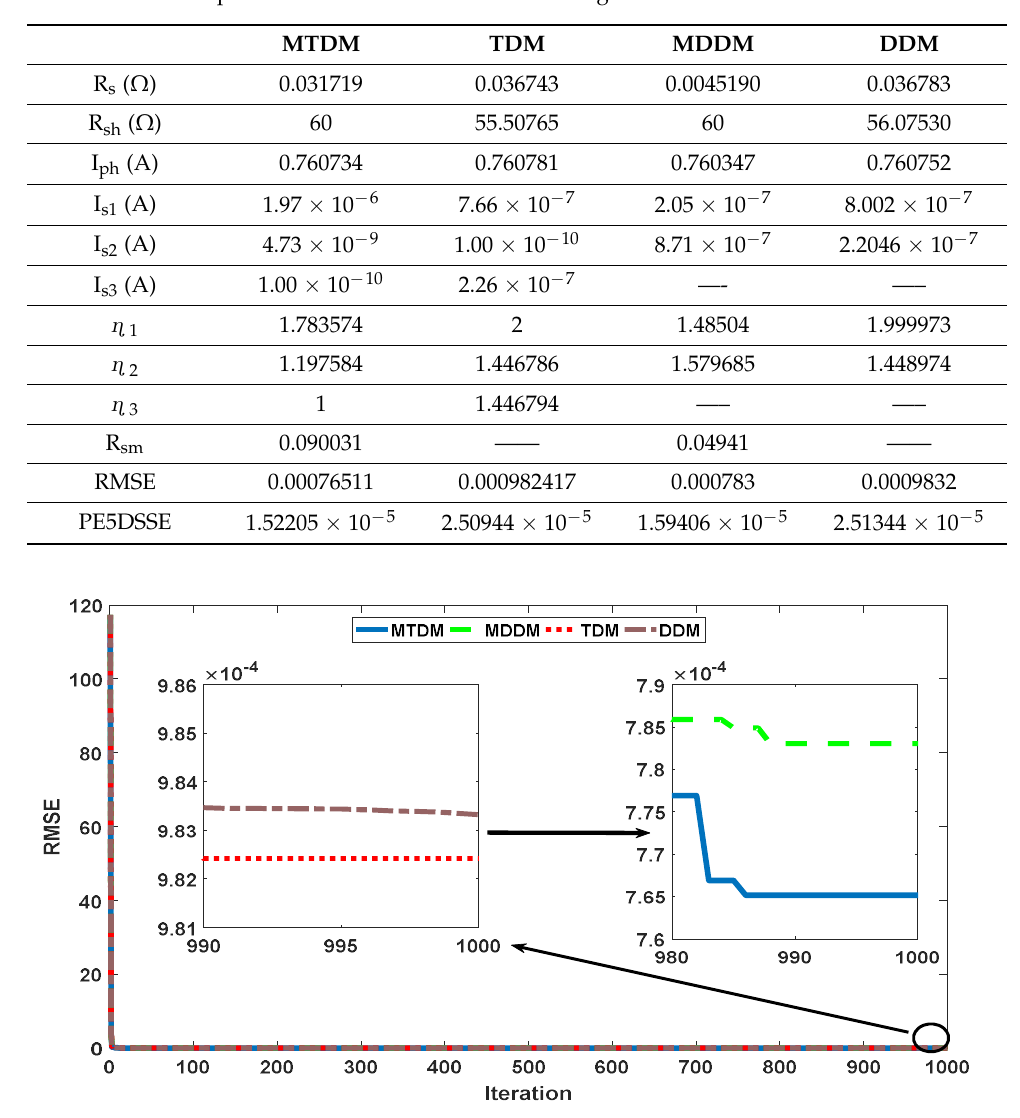
Figure 9. The convergence curve of WHO for all models. Table 3. The statistical results of MTDM for WHO and other algorithms.